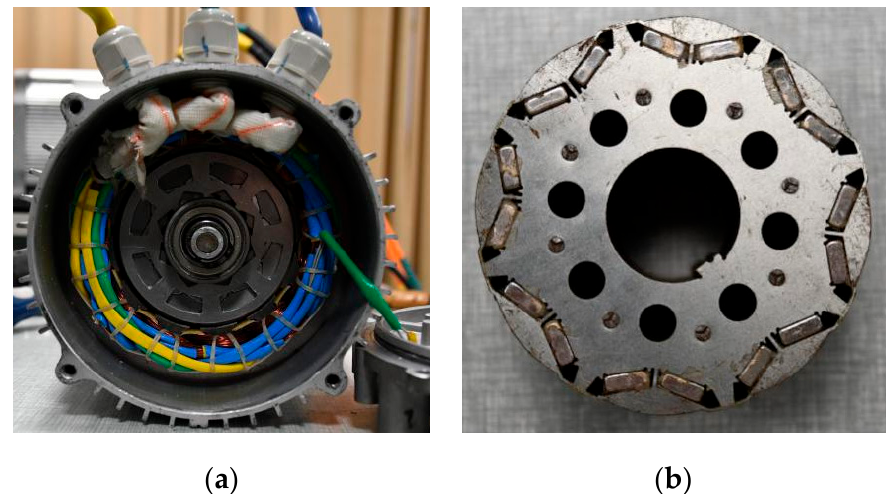
Figure 13. Diagrams of prototype and the rotor: ( a ) Complete machine diagram; ( b ) Rotor diagram.